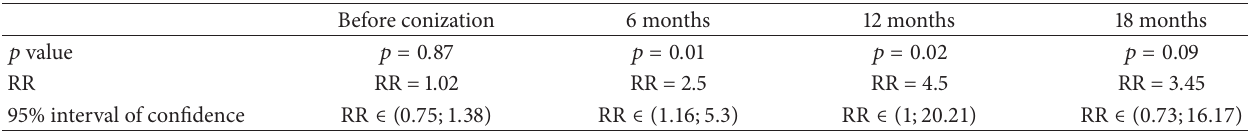
Table 3: The 𝑝 value obtained using 𝜒 2 test, comparing patients positive for HPV type 16 and patients having coinfections (without HPV 16). HPV 16 was correlated with significantly higher risk of persistence ( 𝑝 < 0.5 ) at 6 and 12